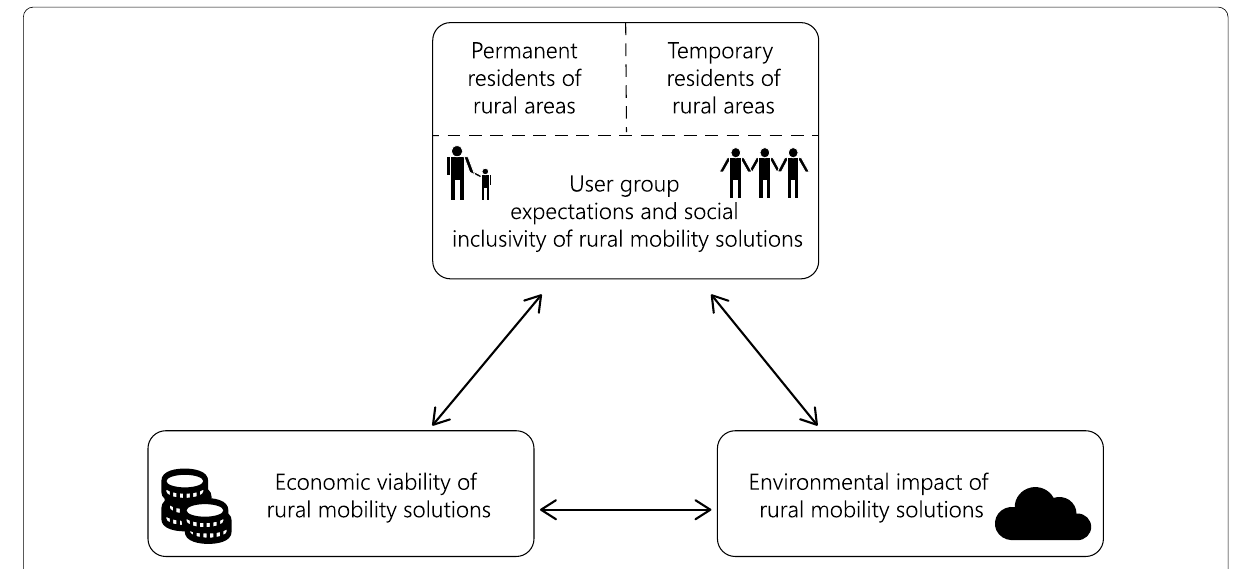
Fig. 1 Sustainability issues in the context of rural mobility